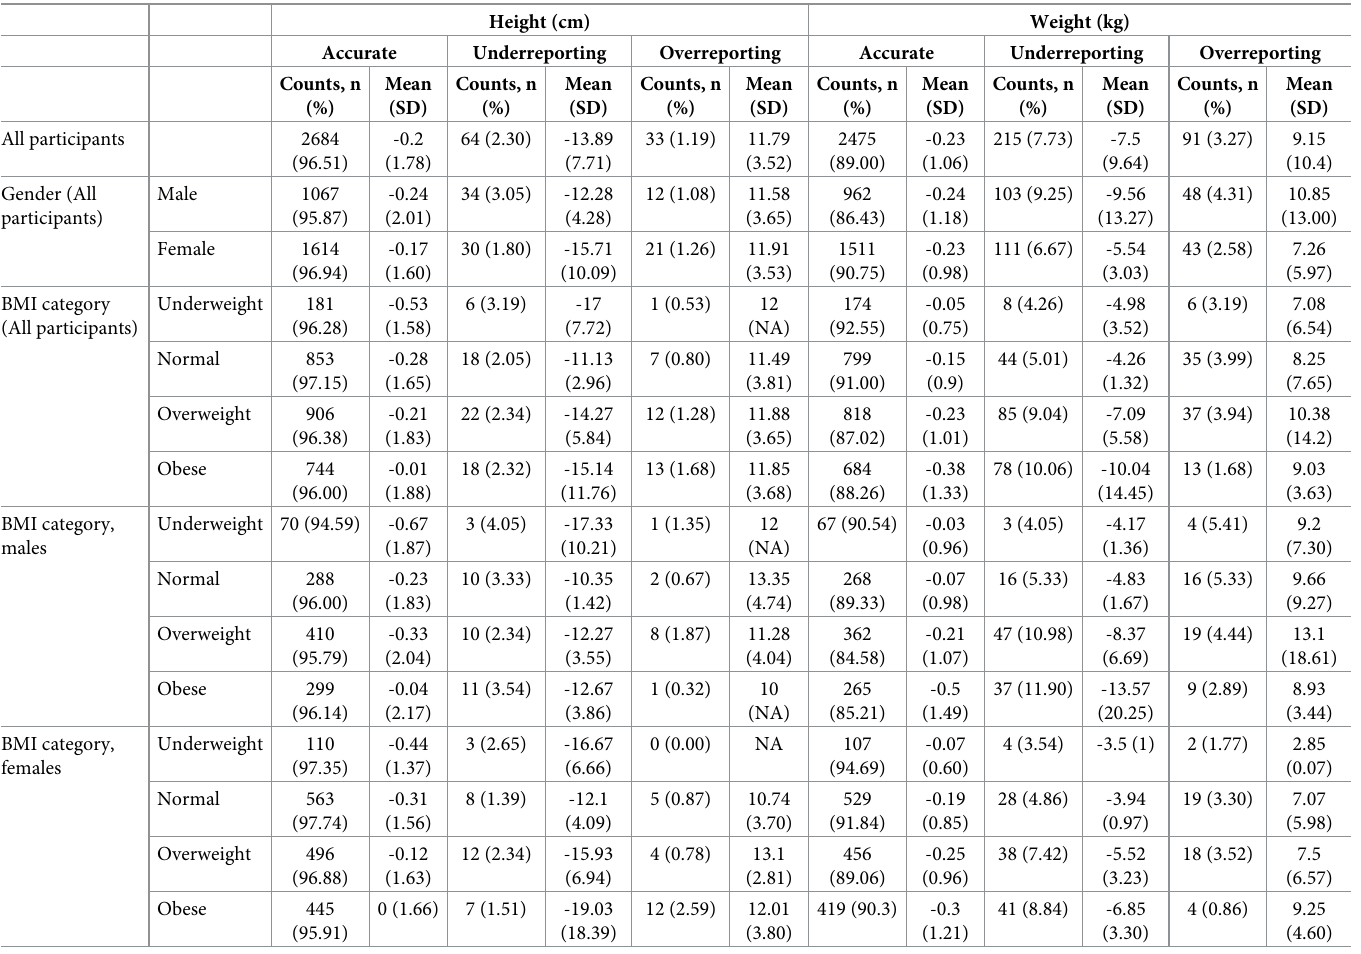
Table 4. Underreporting a and overreporting b of body weight and height by gender and by BMI category. Height (cm) Weight (kg) Accurate